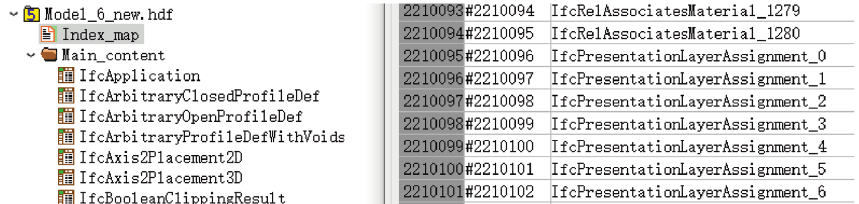
Figure 13: The demonstration of the index map (on the left side is the primary structure of IFC in HDF; on the right side is the index map